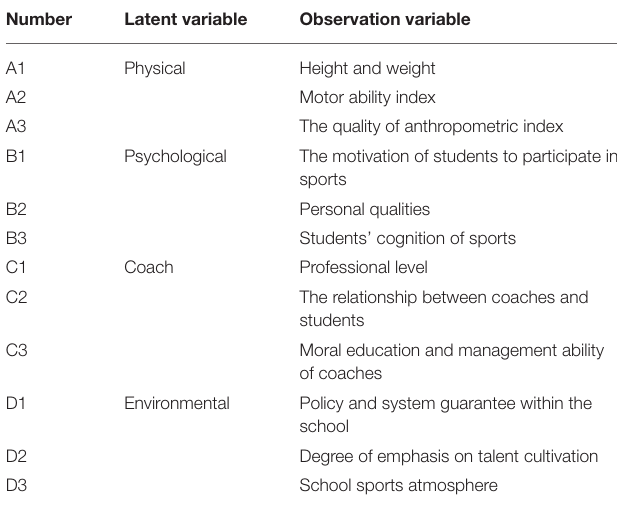
TABLE 1 | Measurement items.